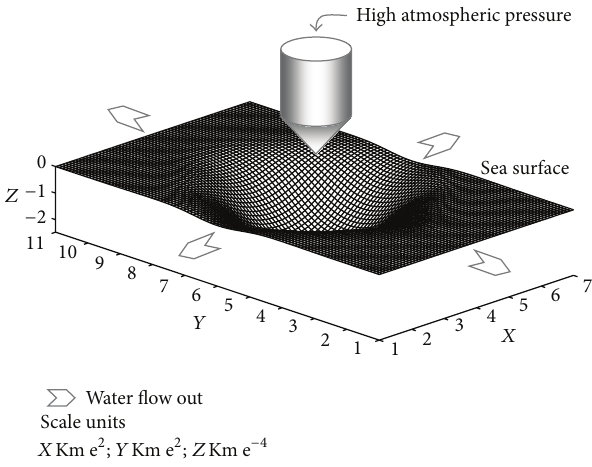
Figure 1: Picture of the geodetic phenomenon of sea level deforma- tion due to atmosphere weight (image from